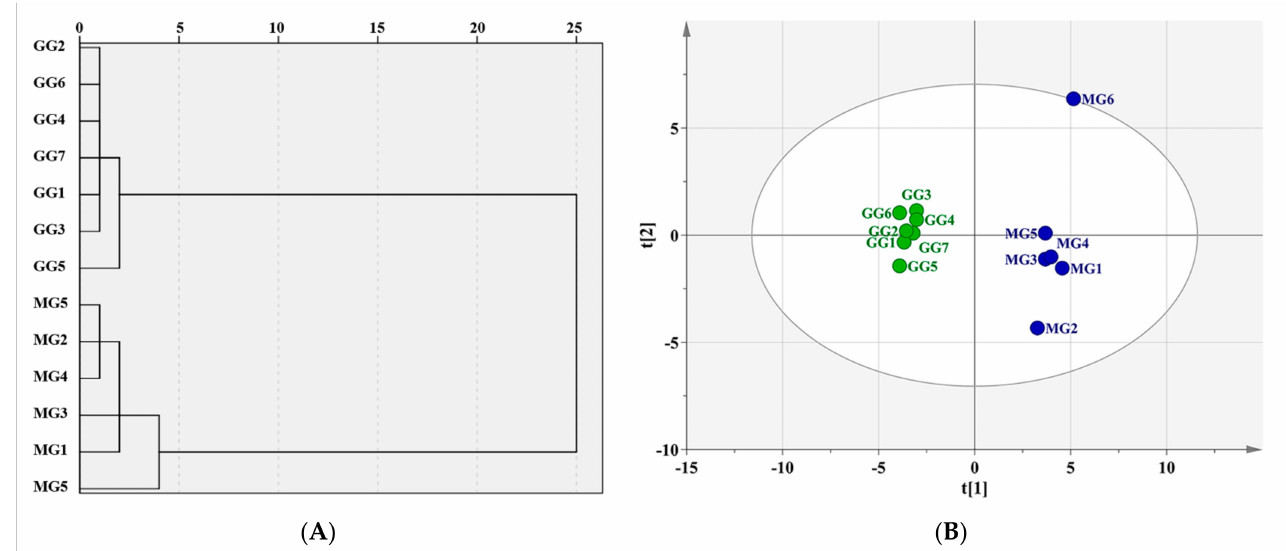
Figure 2. ( A ) HCA dendrogram of the 13 batches of Ginseng ; ( B ) PCA score plots of the 13 batches of Ginseng .